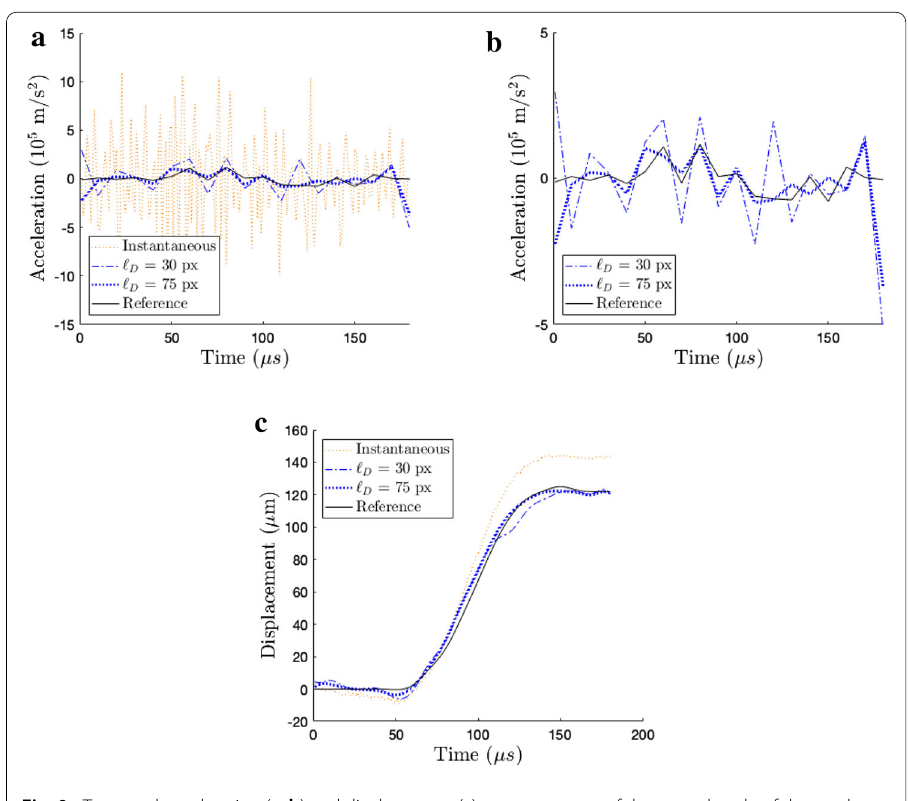
Fig. 9 Temporal acceleration ( a , b ) and displacement ( c ) measurements of the central node of the mesh. The physical size of one pixel is 500 µ m. All regularized analyses better capture the accelerations and displacements. For a larger length, the results are very close to the reference solution